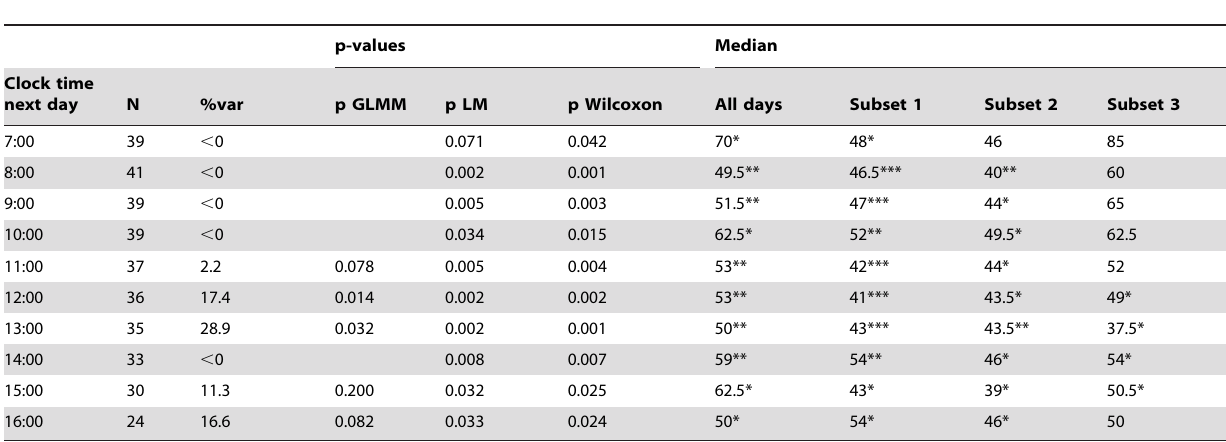
Table 3. Deviation angles between direction of the last spontaneous long call given shortly before nesting and travel direction on the subsequent